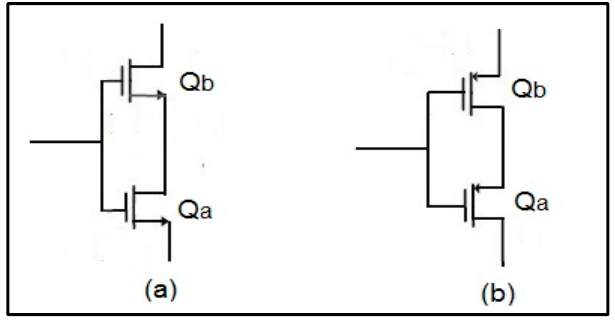
Figure 5. ( a ) NMOS composite transistor ( b ) PMOS composite transistor.